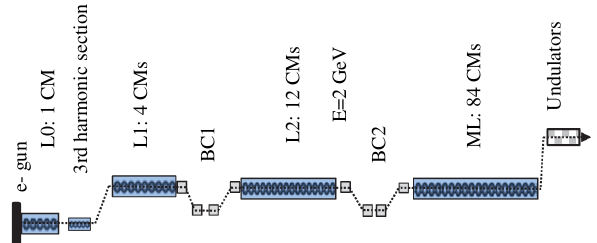
FIG. 1. Layout of the XFEL accelerator. Injector section up to 2 GeV and ML contains 17 CMs and 84 CMs respectively. BC1 and BC2 are bunch